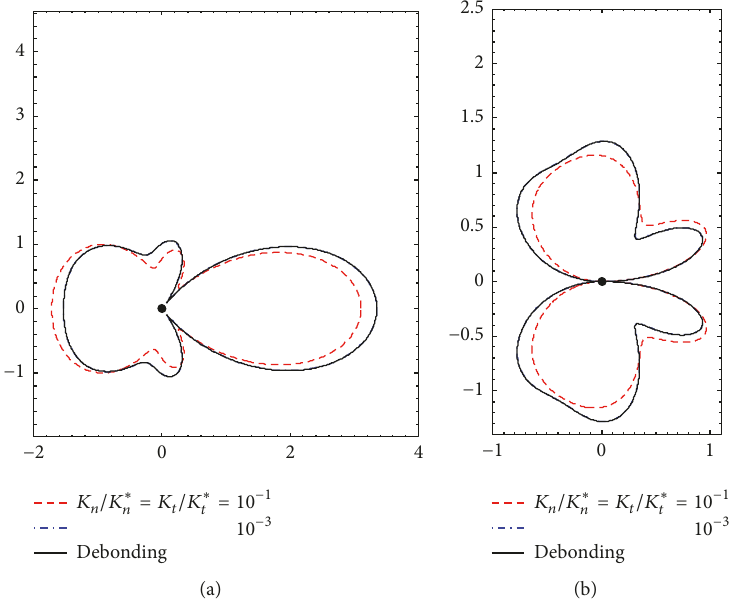
Figure6:Comparisonofthecalculatedfar-fieldscatteringpatternsofthescattered(a)P-waveand(b)SV-wavebyafiberwithafullyimperfect bonding to the matrix under a P-wave incidence versus those of the debonding case (cavity).